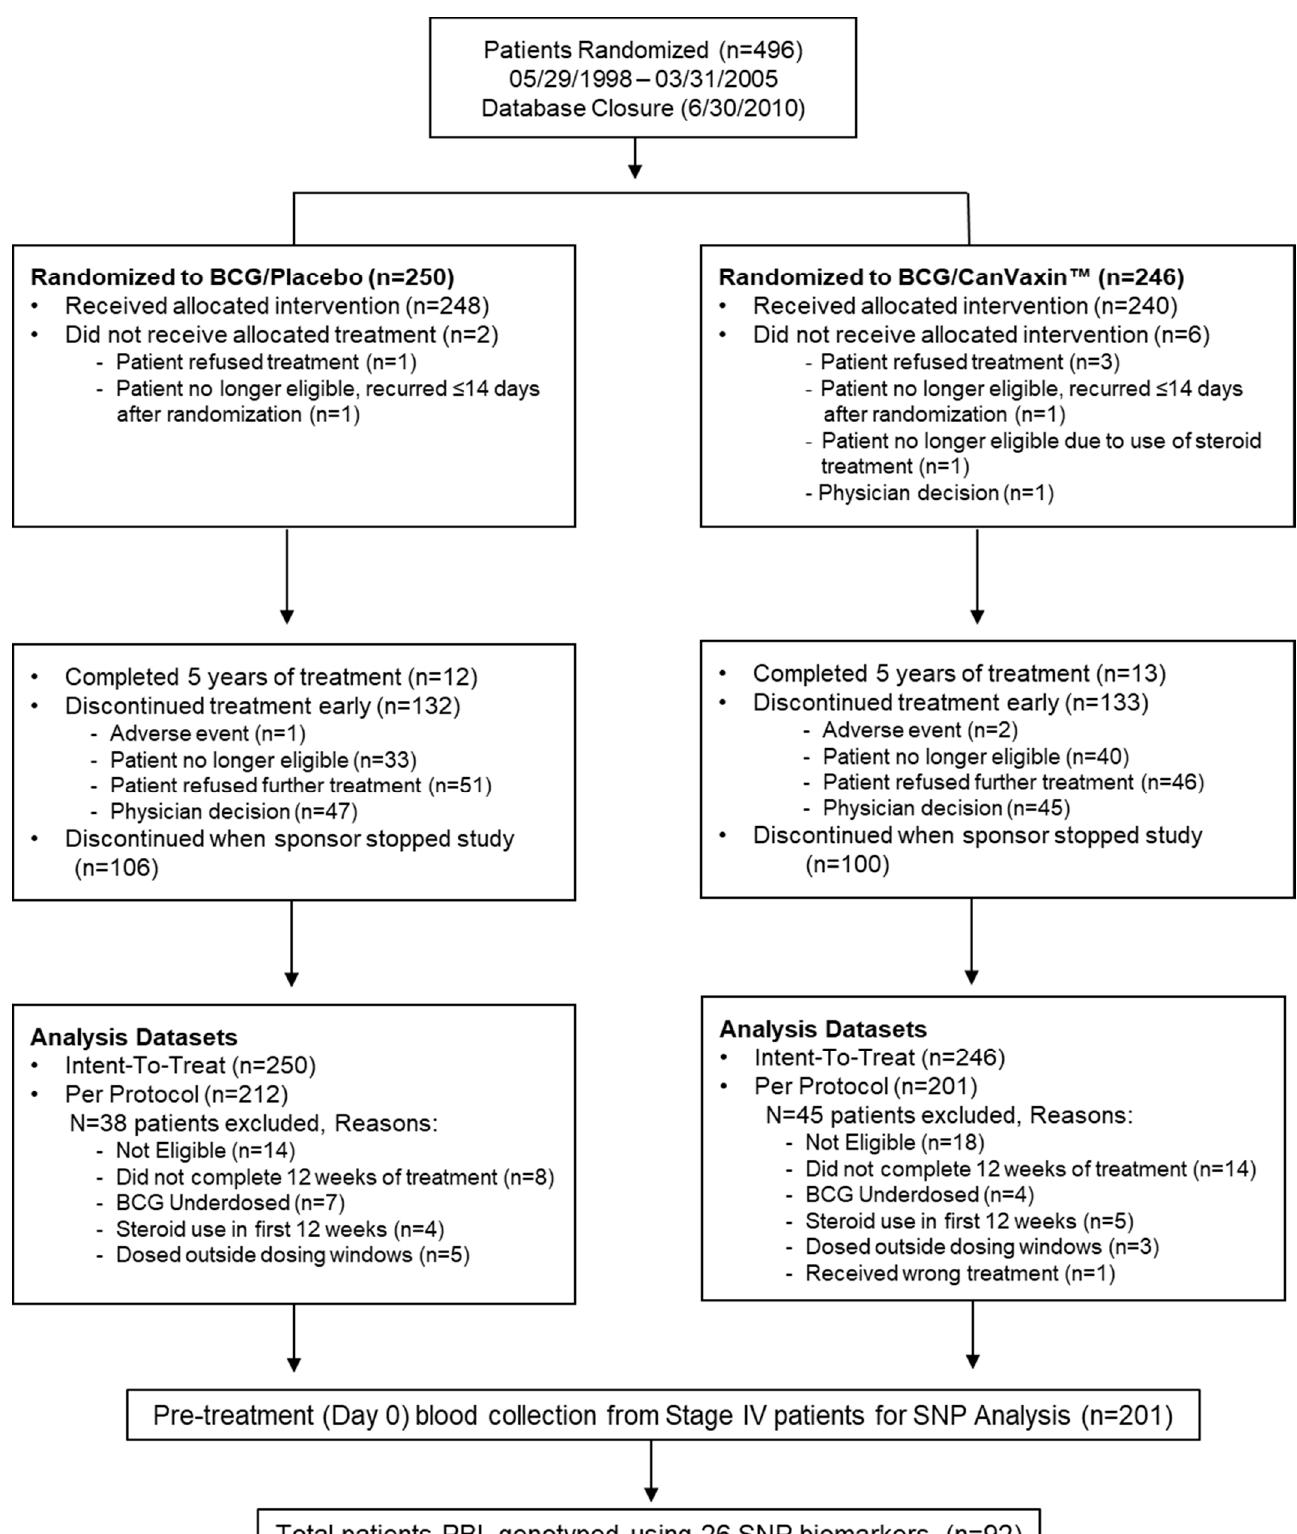
Figure 1. CONSORT diagram of MMAIT-Stage IV patients from the phase III randomized double-blinded international multi-center trial. The flow diagram describing the MMAIT-IV (NCT00052156) trial, is shown. Selected patients ( n = 92) from MMAIT-IV trial were used as a pilot study cohort. MMAIT = Malignant Melanoma Active Immunotherapy Trial; SLN = Sentinel Lymph Node; PBL = Peripheral Blood Leukocytes; SNP = Single Nucleotide Polymorphism.